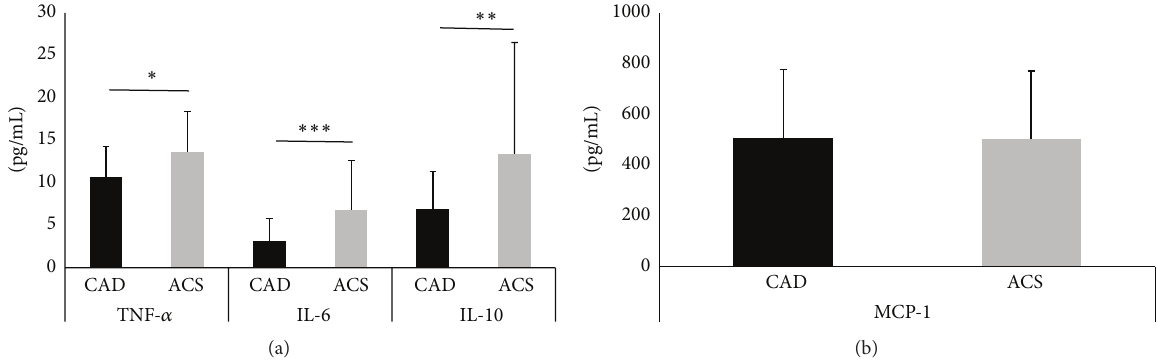
Figure 3: The data are presented as means ± SD. Profile of plasma levels of tumor necrosis factor- 𝛼 (TNF- 𝛼 ), interleukin- (IL-) 6, and IL-10 (a) and of monocyte chemoattractant protein-1 (MCP-1) (b) in coronary artery disease (CAD) and acute coronary syndrome (ACS) groups. ∗ 𝑃 < 0.05 ; ∗∗ 𝑃 < 0.01 ; ∗∗∗ 𝑃 < 0.001 .